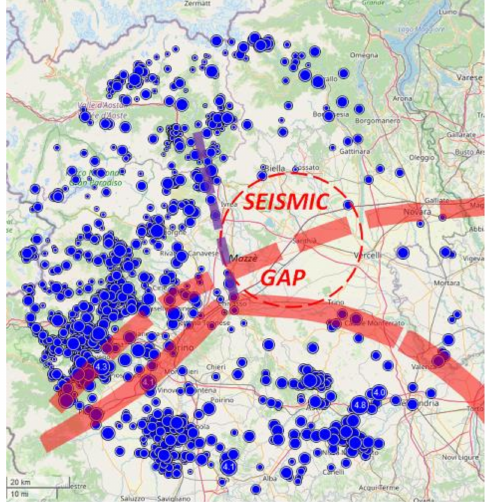
Figure 5. Schematic representation of epicentral positions of seismic events, with ML ≥ 1, observed within a 70 km radius around Mazz è according to the ISIDE-INGV Catalog. The traces of the Apennine Frontal Thrusts (AFT, according to DISS database) and the Median Front of Alpine (MFA) retrovergent units are also